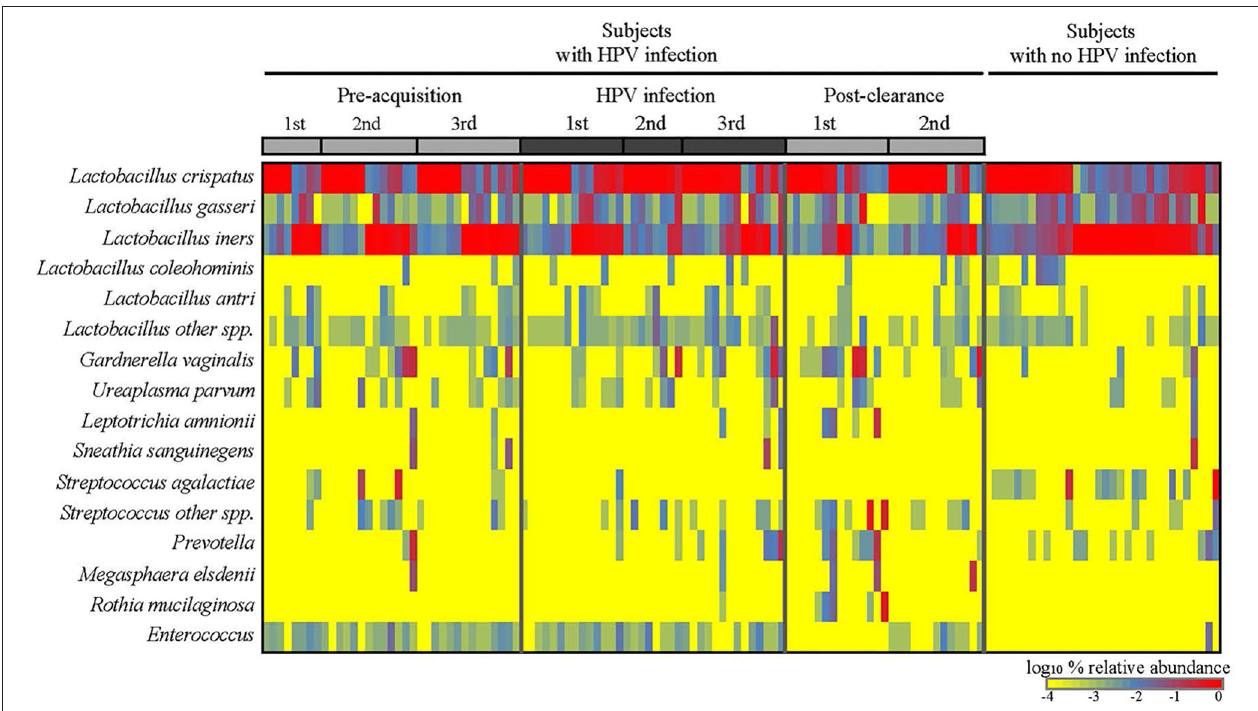
FIGURE 1 | Cervical-vaginal microbiome composition of the women across different HPV states. Relative abundances of the dominant bacterial species detected in the samples by HPV states are as follows: three pre-acquisition visits, two or three visits during infection, one immediate (1st) post-clearance visit, and one later (2nd) post-clearance visit. Samples from the women with no history of HPV infection ever were analyzed as a comparison.